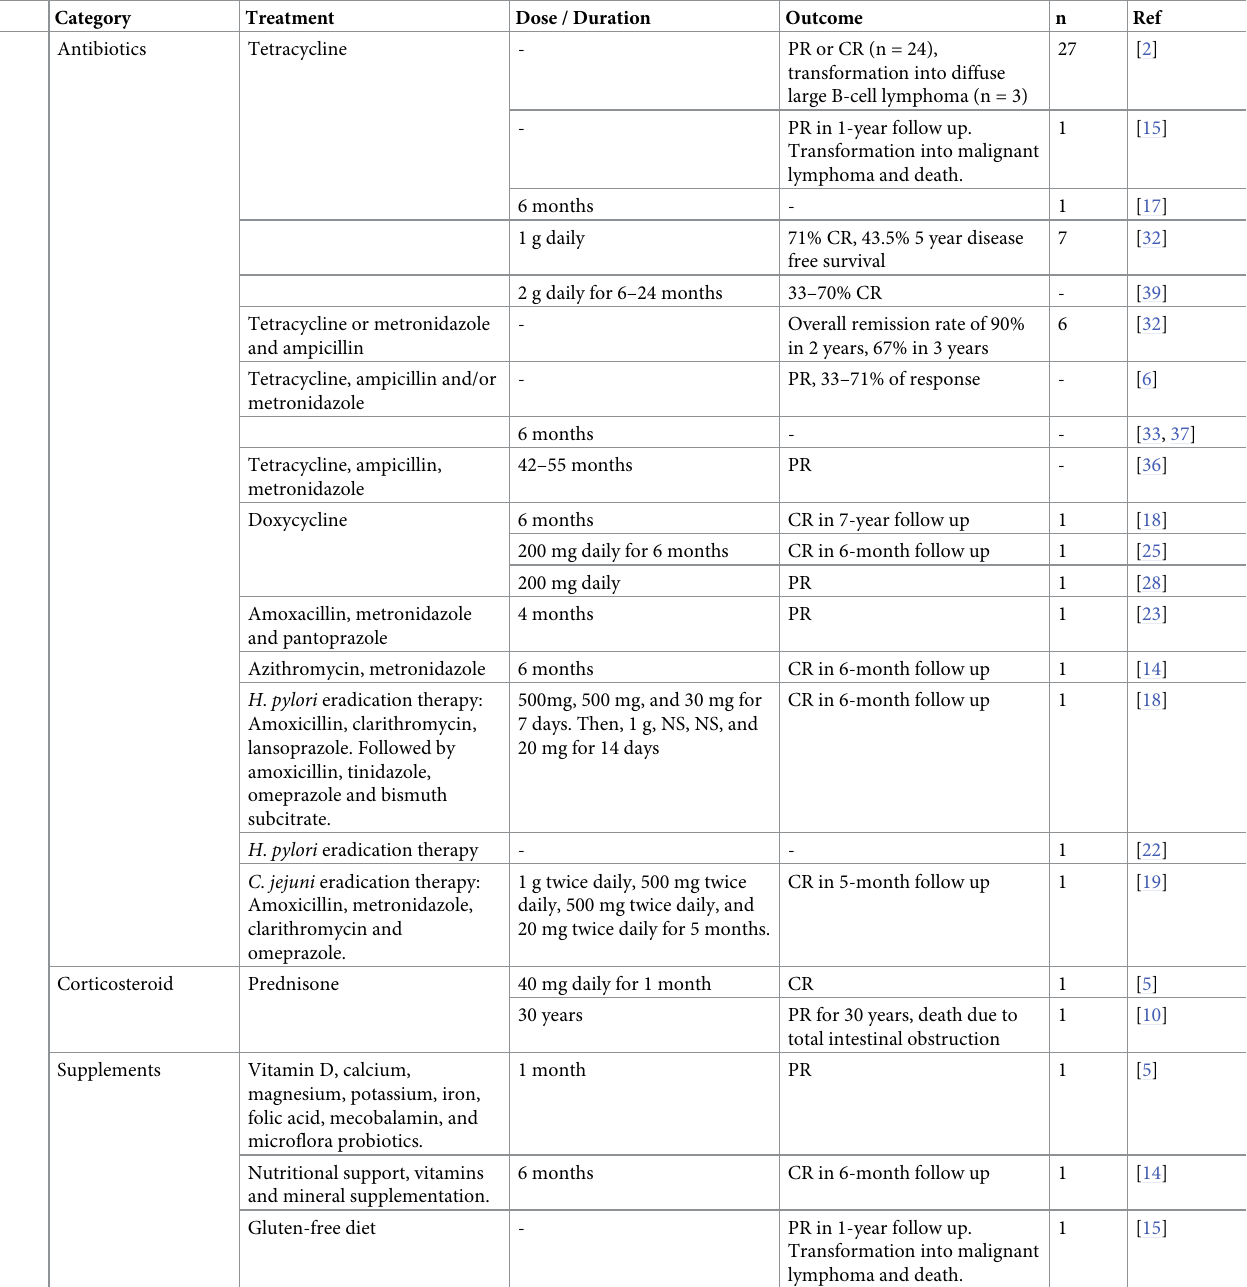
Table 4. IPSID treatment and related outcomes. Galian